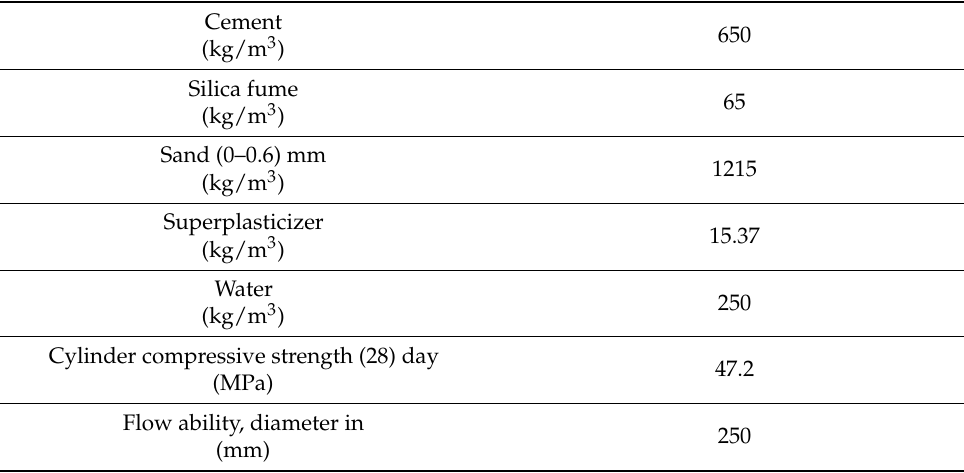
Table 1. Constituents of the fine-grained concrete.